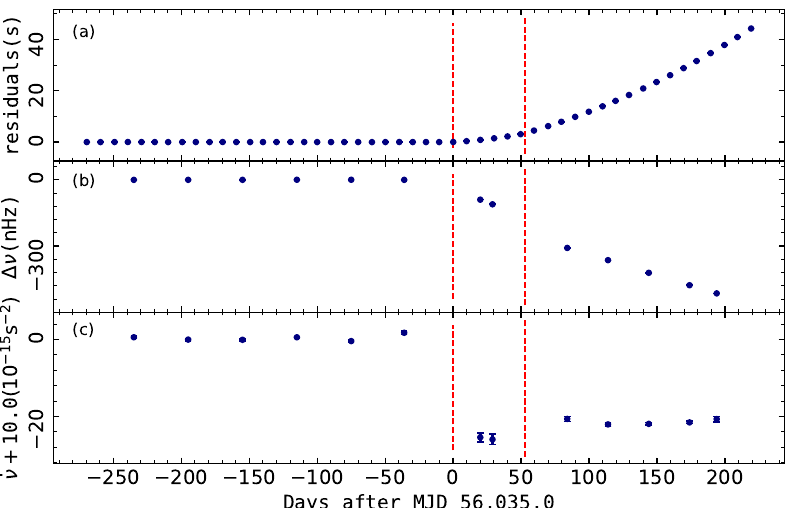
Figure 7. The simulated two anti-glitch in magnetar IE 2259+586 around 2012 [118] : ( a ) timing residuals relative to a spin-down model before anti-glitch; ( b ) the frequency residuals ∆ ν ; ( c ) the spin-down rate ˙ ν of before and after the anti-glitch. The red vertical dashed lines mark the glitch epochs: 56,035 [118], 56,088.4